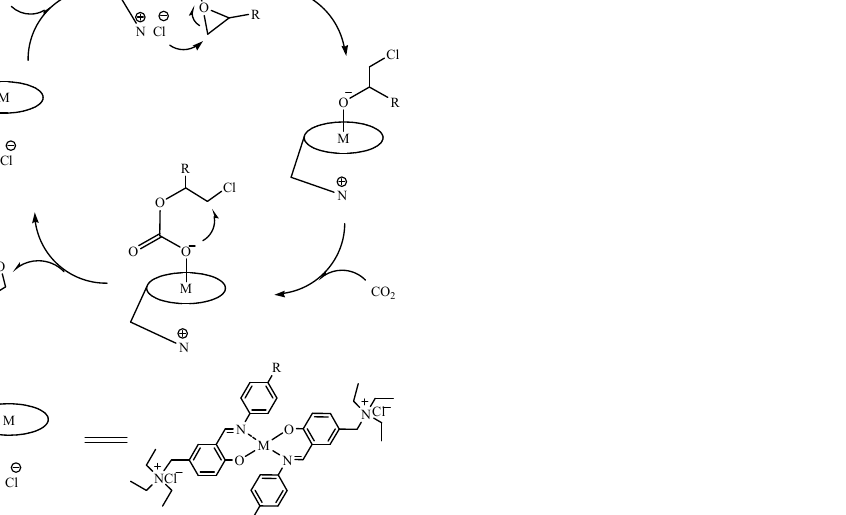
of the materials. Table S2: Structure of ligands. Table S3: Structure of catalysts. Figure S1: 1 H NMR and 13 C NMR spectra for NPCl in DMSO-d6. Figure S2: 1 H NMR and 13 C NMR spectra for Zn-NPClH in DMSO-d6. Figure S3: 1 H NMR spectrum for Zn-NPClCH 3 in DMSO-d6. Figure S4: 1 H NMR and 13 C NMR spectra for Zn-NPClCl in DMSO-d6. Figure S5: 1 H NMR spectrum for Zn-NPClNO 2 in DMSO-d6. Figure S6: 1 H NMR and 13 C NMR spectra for Zn-NPClC 4 H 9 in